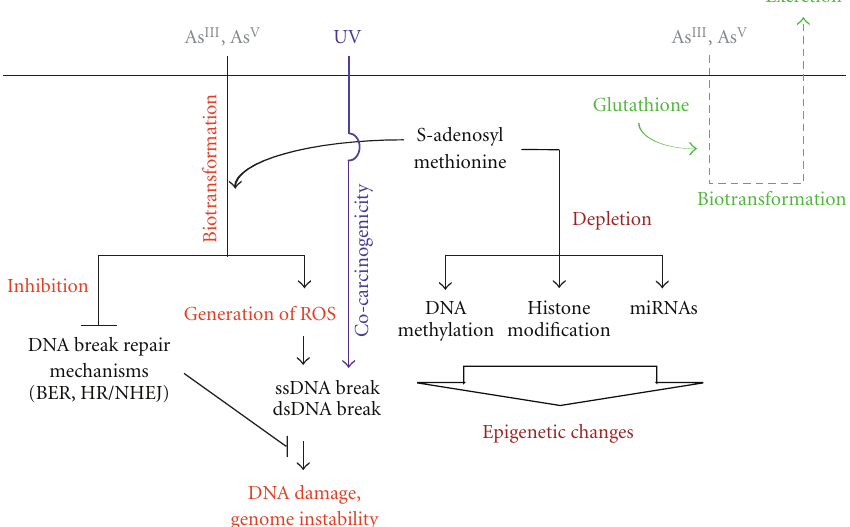
Figure 1: Carcinogenic mechanisms of arsenic transformation. Ingested arsenic undergoes a biotransformation process. (1) Biotransforma- tion could lead to arsenic excretion, when conjugated with glutathione. (2) Biotransformation generates reactive oxygen species (ROS), namely, superoxide anions (O 2 − ), hydrogen peroxide (H 2 O 2 ), hydroxyl radicals (OH), that induce single-strand (ssDNA) and double- strand (dsDNA) breaks by inducing oxidative damage. The process can also inhibit DNA break repair mechanisms for ssDNA breaks (base excision repair (BER)) and for dsDNA breaks (homologous recombination (HR) and/or nonhomologous end joining (NHEJ)). Additionally, ROS derived from arsenic biotransformation can act as cocarcinogens, for example, increasing damage potential of ultraviolet (UV) light. Furthermore, the requirement of S-adenosyl methionine (SAM) for arsenic biotransformation can lead to depletion of SAM, which is the substrate for DNA